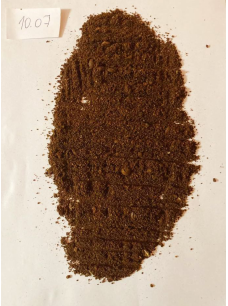
Figure 17. Coffee beans ground for about 10 s.